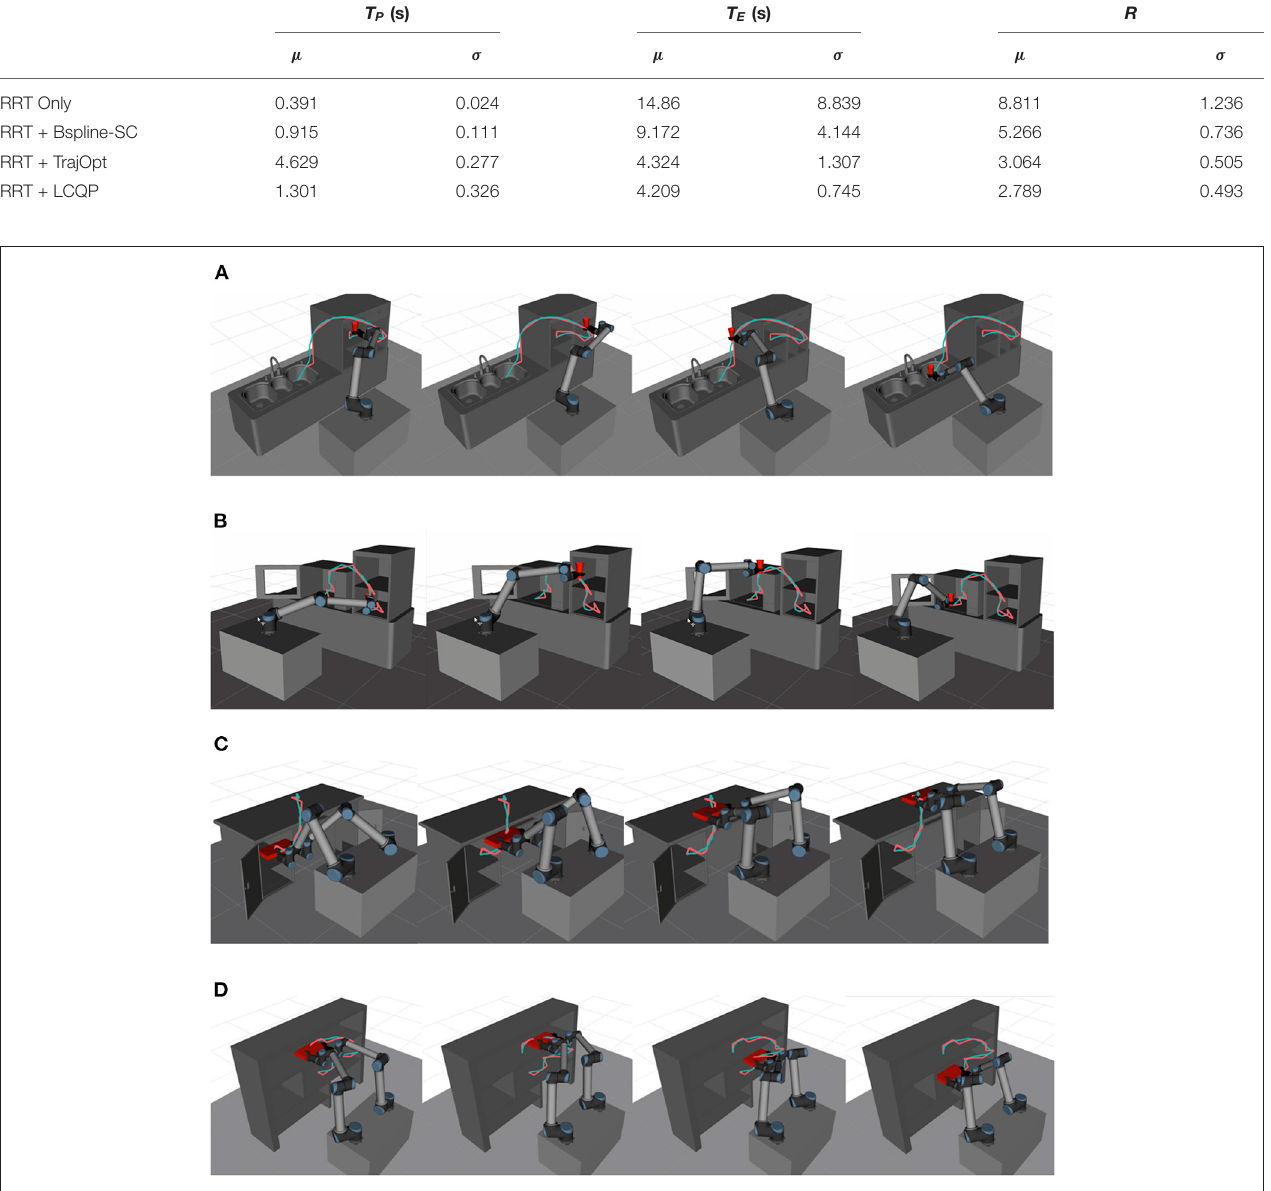
TABLE 3 | Results of the robot experiments.